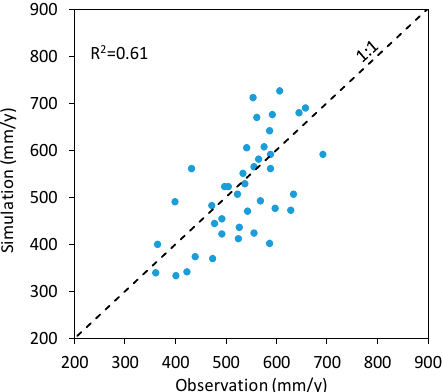
Figure 8. Scatter plot of the measured and simulated annual irrigation water depths (mm/year) for paddy fields at eight experimental stations from 2008 to 2012. The annual irrigation water depth is the ratio of the volume of irrigation water entering the farmland to the area of the